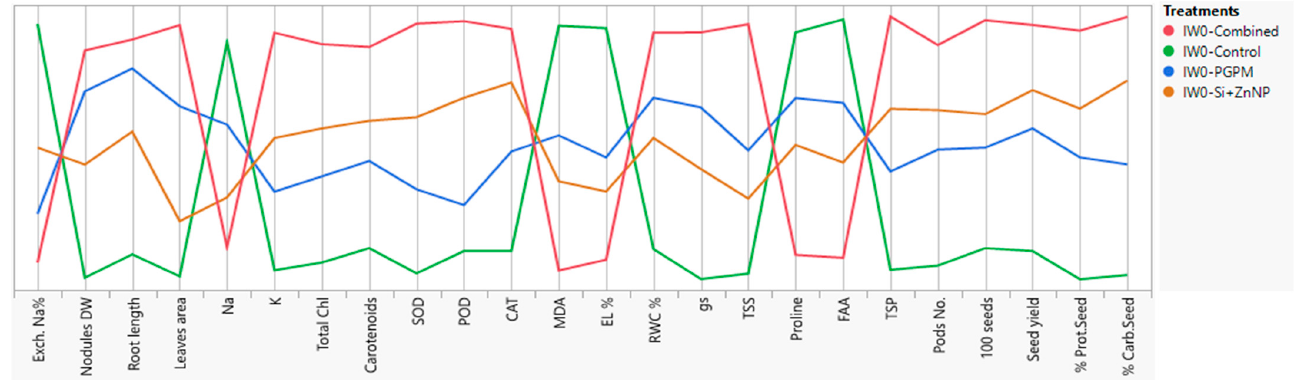
Figure 8. Parallel coordinates comparison plot showing how the studied variables of soybean grown under well irrigation changes in relation to the type of growth promoters (PGPMs and/or Si-ZnNPs).